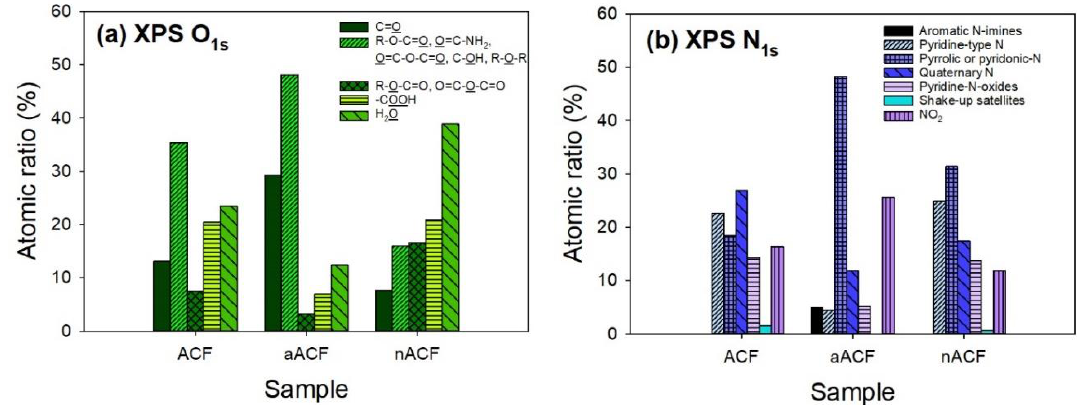
Figure 4. Results of the fits of the high resolutions X-ray photoelectron spectroscopy (XPS): ( a ) O 1s region; ( b ) N 1s region. The values were given in the atomic ratio (%) of total intensity.